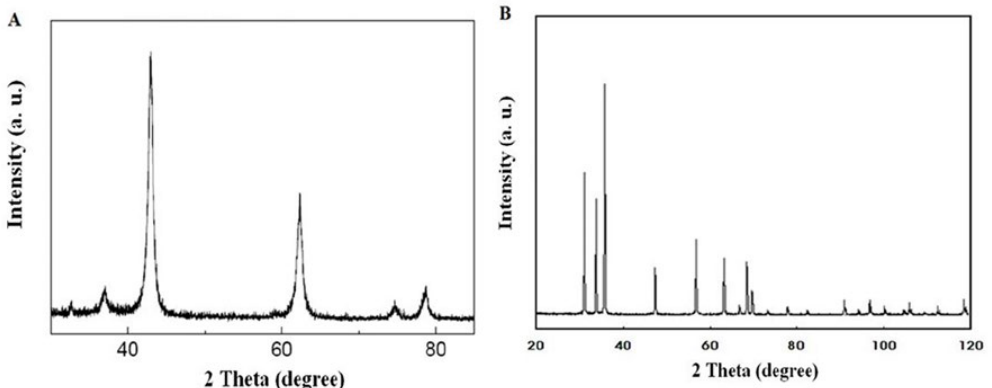
Fig.1. XRD patterns of MgO NPs (A) and ZnO NPs (B). Fig. 1. XRD patterns of MgO NPs (A) and ZnO NPs